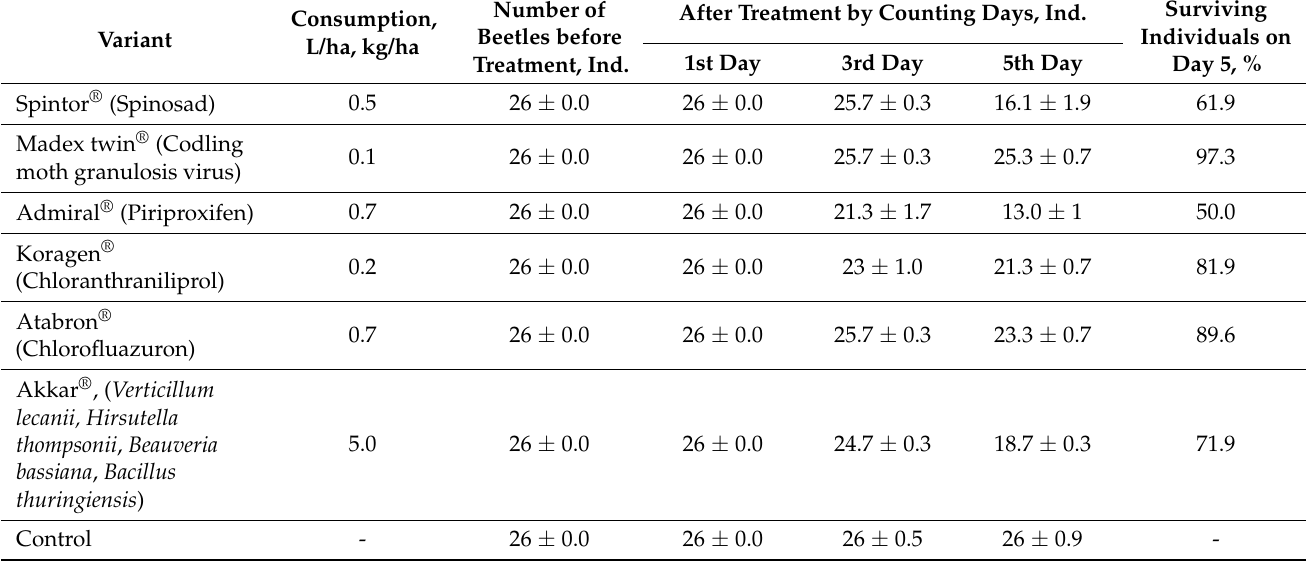
Table 6. Sensitivity of adult H. axyridis to biological and biorational insecticides.